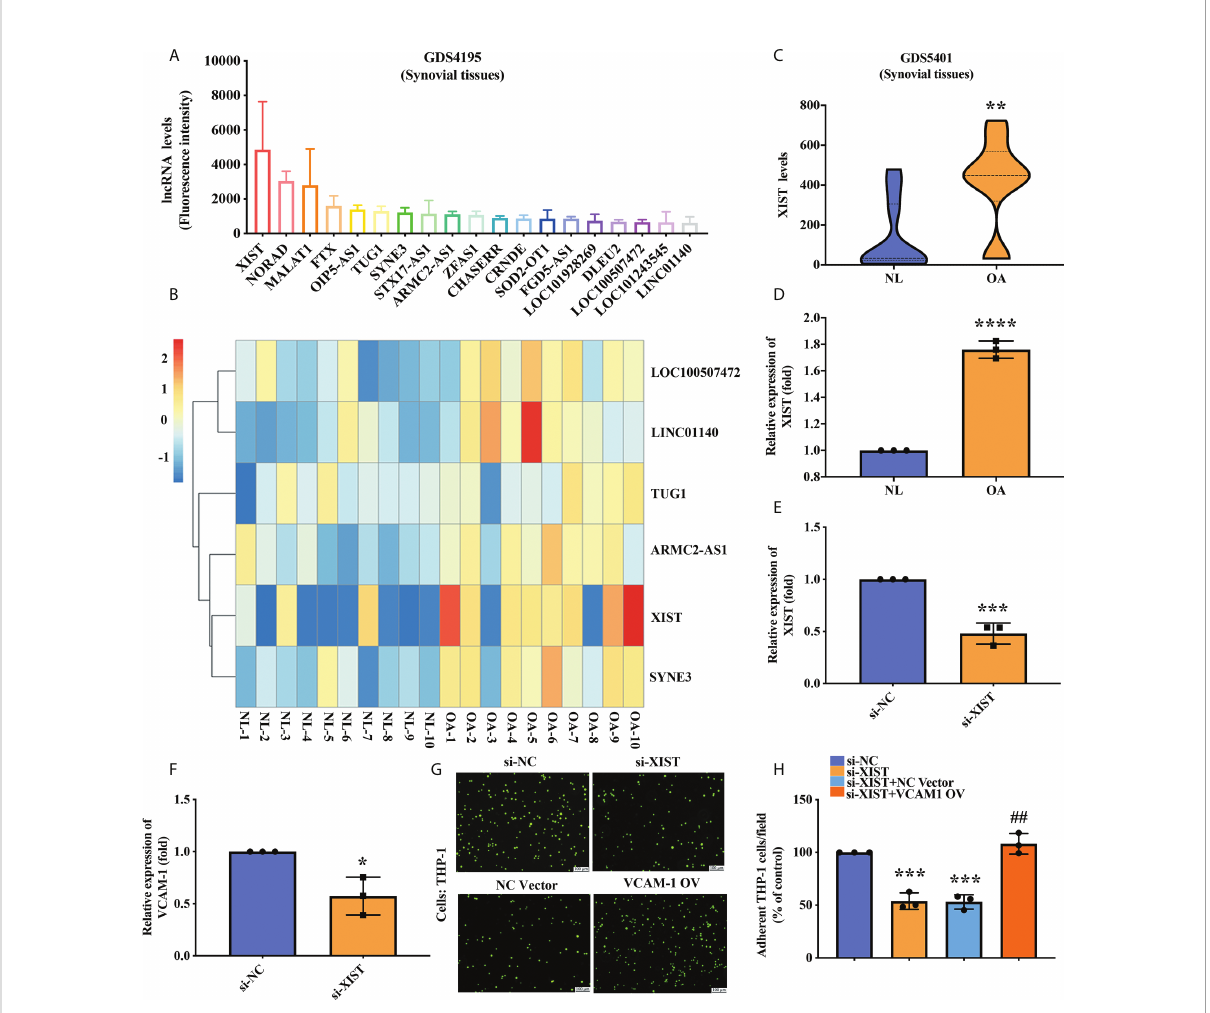
FIGURE 2 Higher levels of XIST expression in OA synovial tissue and knockdown of XIST inhibited VCAM-1-mediated monocyte adherence. (A) An analysis of the GEO dataset GDS4195 identi fi ed the top 20 upregulated lncRNAs in human OA synovial tissue specimens (n = 5). (B) A cluster heat map shows lncRNA expression in human synovial tissue (red denotes higher expression and blue denotes lower expression) from the GEO dataset GDS5401. (C) Levels of XIST expression in OA (n = 10) and healthy synovial tissue (n = 10) samples from GDS5401. (D) Total RNA for each sample of human synovium was extracted using TRIzol reagent. Levels of XIST were quanti fi ed by RT-qPCR assay (n = 3). (E, F) OASFs were transfected with XIST siRNA for 24 h. The RT-qPCR assay measured XIST and VCAM-1 expression (n = 3). (G) OASFs were co-transfected with XIST siRNA and the VCAM-1 OV plasmid for 24 h. THP-1 cells were labeled with the green fl uorescence BCECF-AM (10 m M) for 1 h. After washing the unlabeled THP-1 cells, they were resuspended in a serum-free RPMI medium and then co-cultured with OASFs for 1 h. Fluorescence intensity was measured by Zeiss AxioPhot fl uorescence microscopy in the images and quanti fi ed by ImageJ processing software in three independent experiments (H) . TUG1, taurine upregulated gene 1. * p < 0.05, ** p < 0.01, *** p < 0.001, **** p < 0.0001 compared with control siRNA; ## p < 0.01 compared with XIST